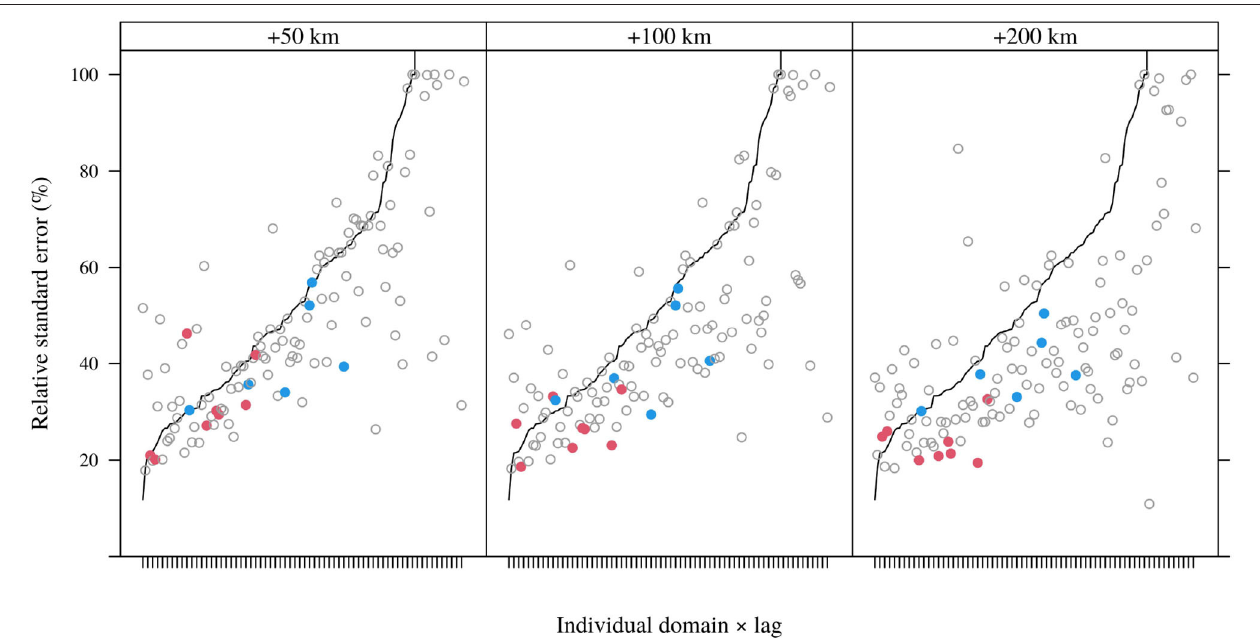
FIGURE 5 | Estimated relative standard errors of augmented sample means for 10-year domains (all lags) under for different spatial buffers; domains and lags are ordered according to relative standard errors of domain means (as represented by the black curve). Horizontal axis labels are individual domain and lag identities and have been suppressed for clarity.